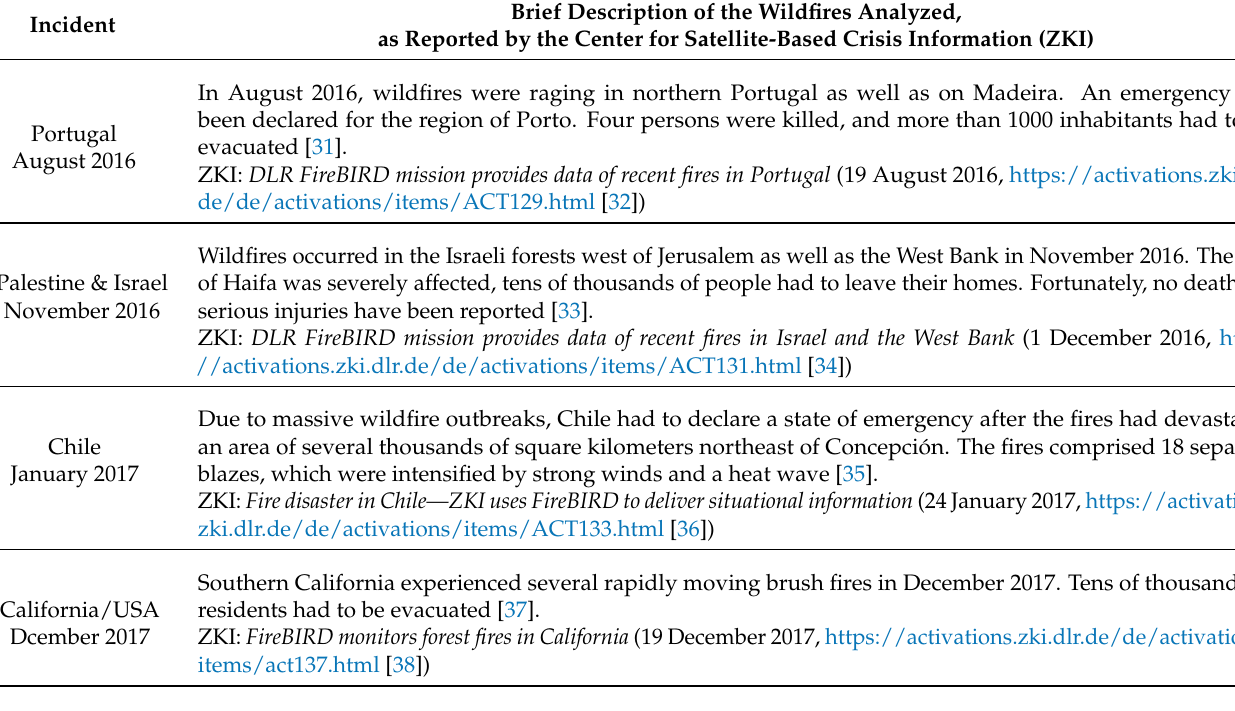
Table 2. Description of study